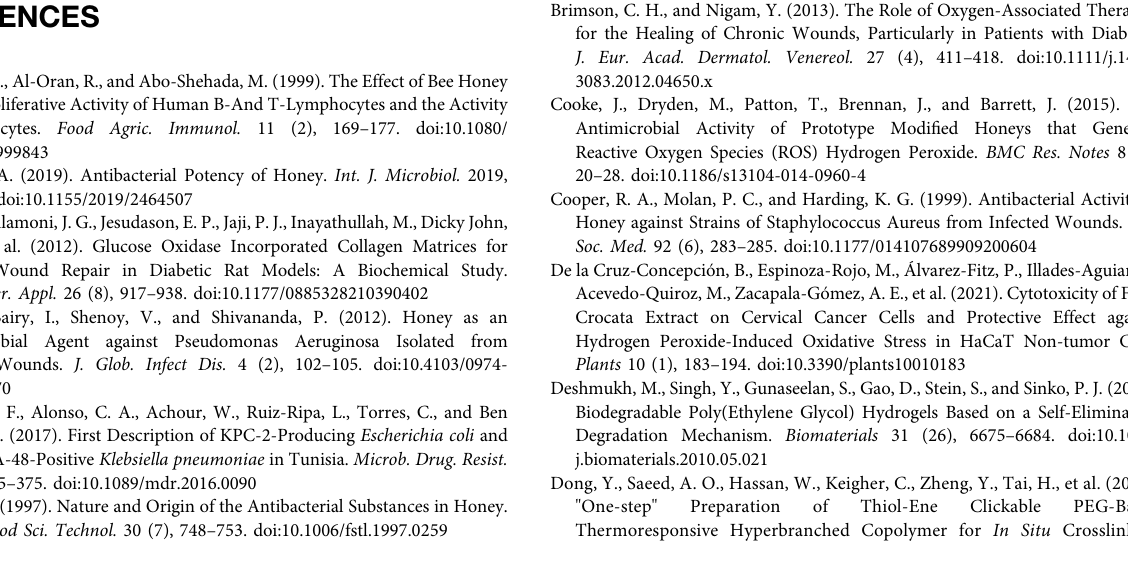
Supplementary Figure 2| Colorimetric measurement of in situ generated H 2 O 2 . Supplementary Figure 3 | Calibration curve of H 2 O 2 obtained by the pertitanic acid assay. Supplementary Figure 4 | 1 H NMR spectrum of synthesized HB PEGDA (Mw 16,656 Da). Supplementary Figure 5 | (A) Bright- fi eld micrographs of L929 cells after 24 h interaction with H 2 O 2 -releasing HB PEGDA/ HA-SH 10.0 – 1.0 hydrogels containing different amounts of GO (25 – 500 U/L) and constant G amount (2.5% w/w) versus controls (TCPS and lysis controls). (B) Fluorescent micrographs of Live/Dead- stained L929 cells after 24 h interaction with H 2 O 2 -releasing HB PEGDA/ HA-SH 10.0 – 1.0 hydrogels containing different amounts of GO (25 – 500 U/L) and constant G amount (2.5% w/w) versus controls (TCPS and lysis controls). Supplementary Figure 6 | (A) Bright- fi eld micrographs of HaCaT cells after 24 h interaction with H 2 O 2 -releasing HB PEGDA/ HA-SH 10.0 – 1.0 hydrogels containing different amounts of GO (25 – 500 U/L) and constant G amount (2.5% w/w) versus controls (TCPS and lysis controls). (B) Fluorescent micrographs of Live/Dead- stained HaCaT cells after 24 h interaction with H 2 O 2 -releasing HB PEGDA/ HA- SH 10.0 – 1.0 hydrogels containing different amounts of GO (25 – 500 U/L) and constant G amount (2.5% w/w) versus controls (TCPS and lysis